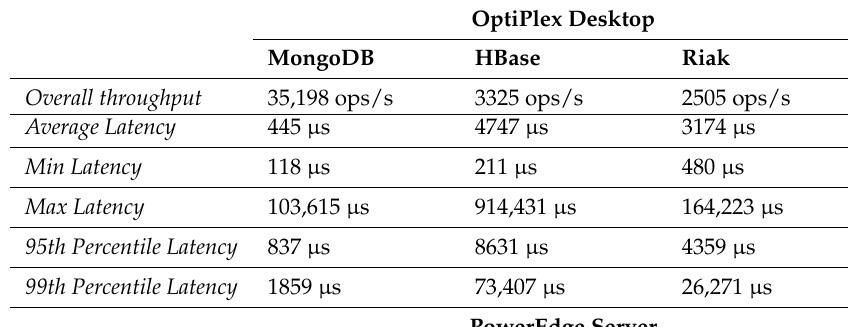
Table 3. Performance of a stand-alone MongoDB, HBase and Riak database on a OptiPlex desktop and PowerEdge server (workload